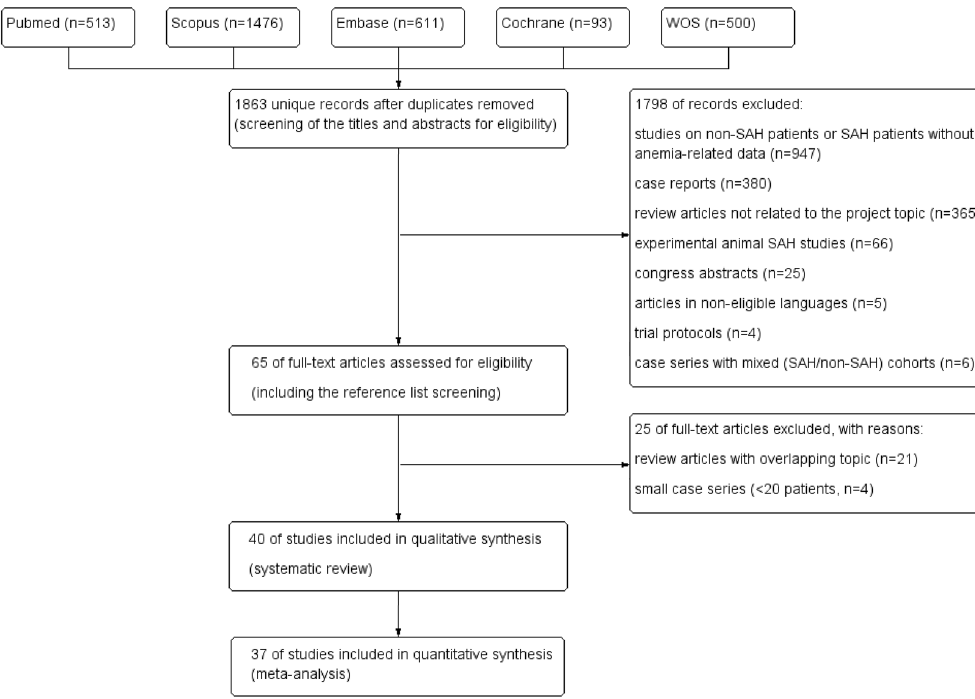
Figure 1. Flow-chart with the selection process of the eligible studies. SAH subarachnoid hemorrhage, WOS web of